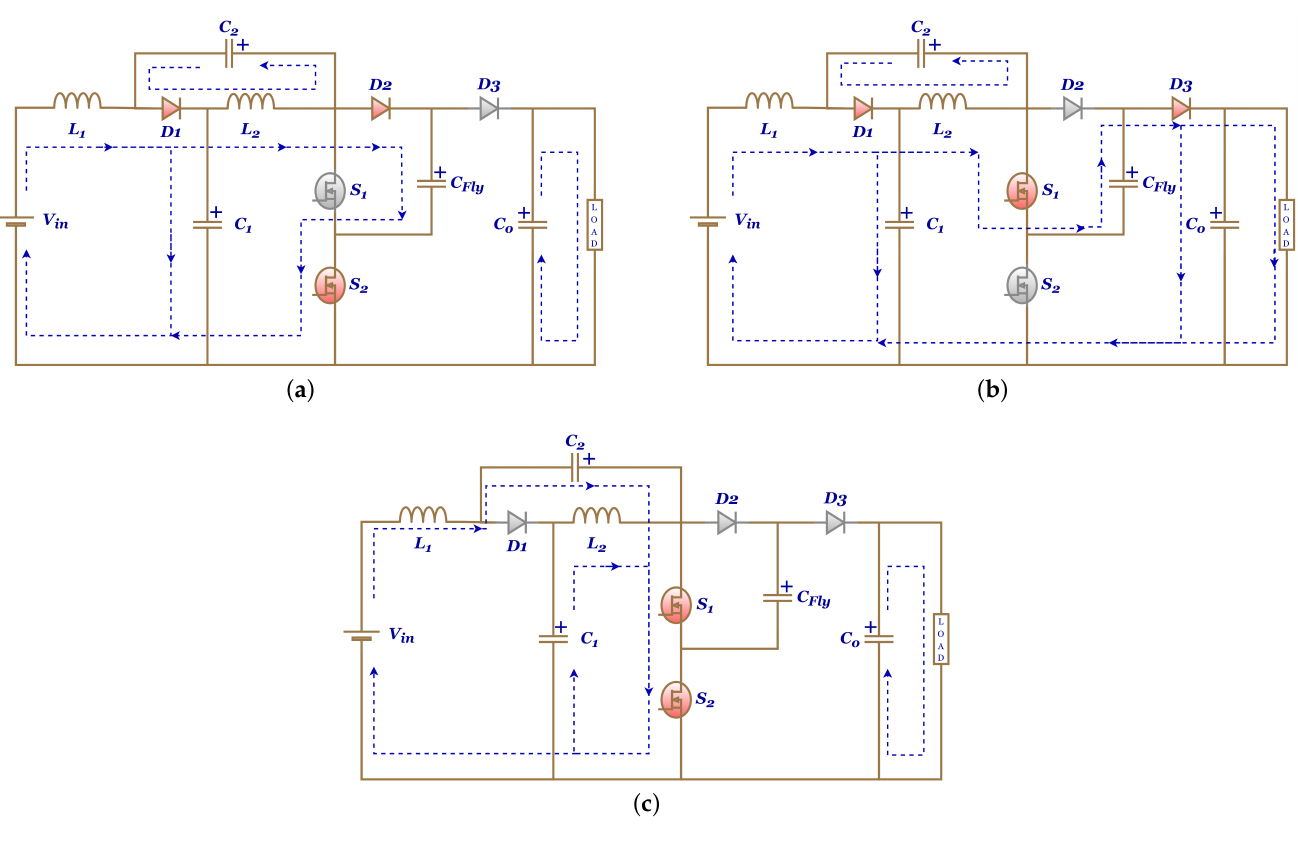
Figure 9. 1st M-TLBC operation: ( a ) S 2 closed, ( b ) S 1 closed, and ( c ) S 1 and S 2